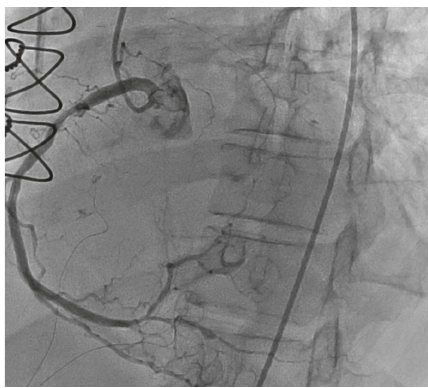
Figure 5: Left heart catheterization identifying worsening disease of RPDA after